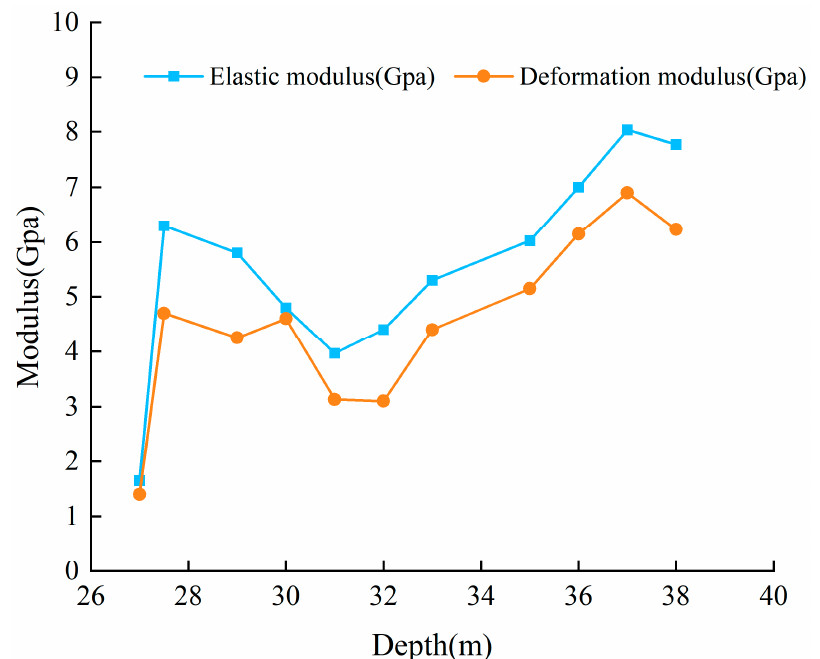
Figure 6. Variation of the average modulus with the depth. The field pressure plate test location, borehole deformation method test location, and acoustic test data are merged into the borehole TV map for comparison and additional analysis. The green line shows the borehole deformation technique test result and test site, while the red line shows the acoustic test result. After the TV results of six boreholes, it was found that four of them had deformation tests of less than 2 GPa, as shown in Figure